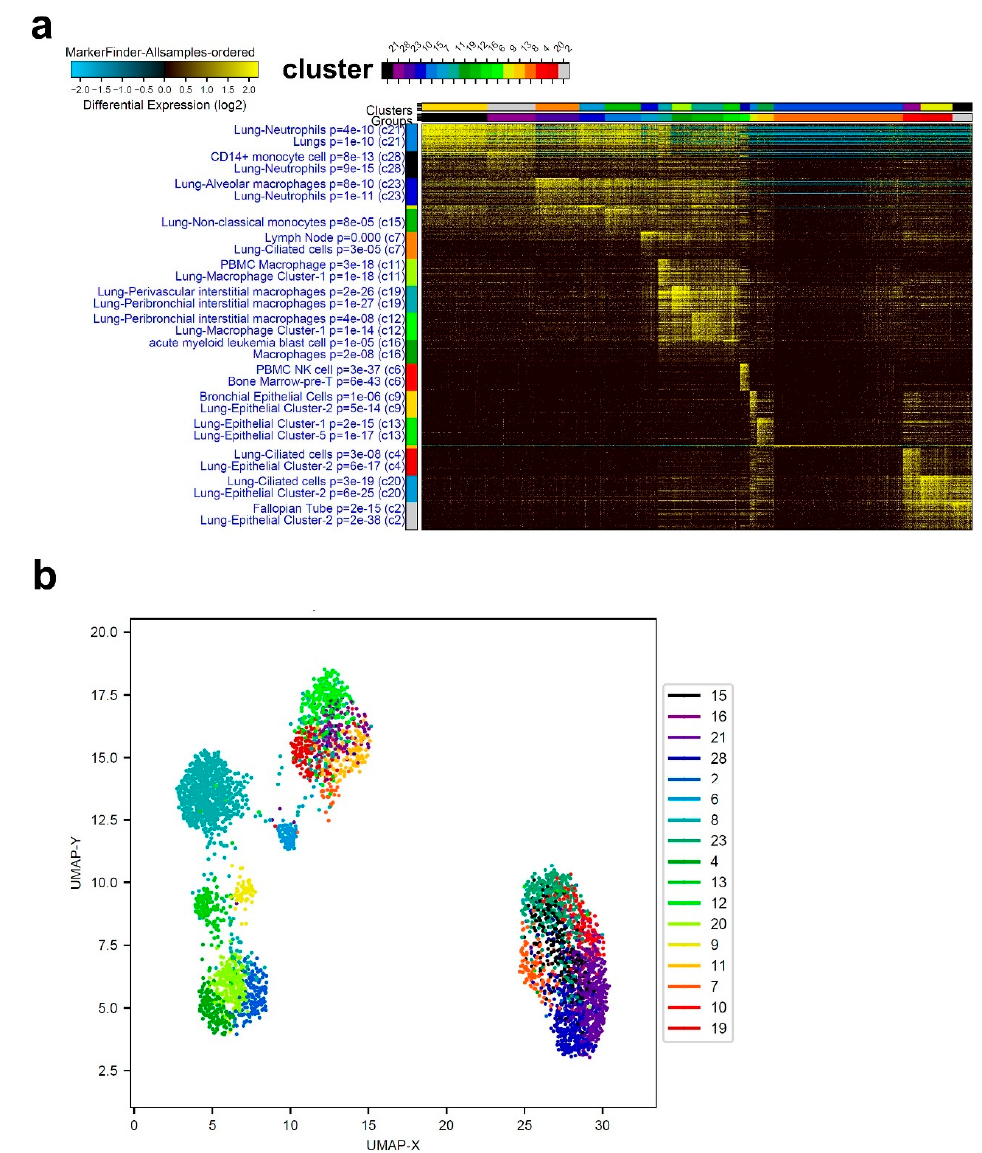
Figure 3. Representative single-cell analysis of BAL from a severe-COVID-19 patient. ( a ) Representative single-cell analysis of BAL from a severe COVID-19 patient employing the ICGS2 algorithm depicted as heat map. ( b ) UMAP dimensionality reduction visualization of cell clusters corresponding to data presented in panel a.